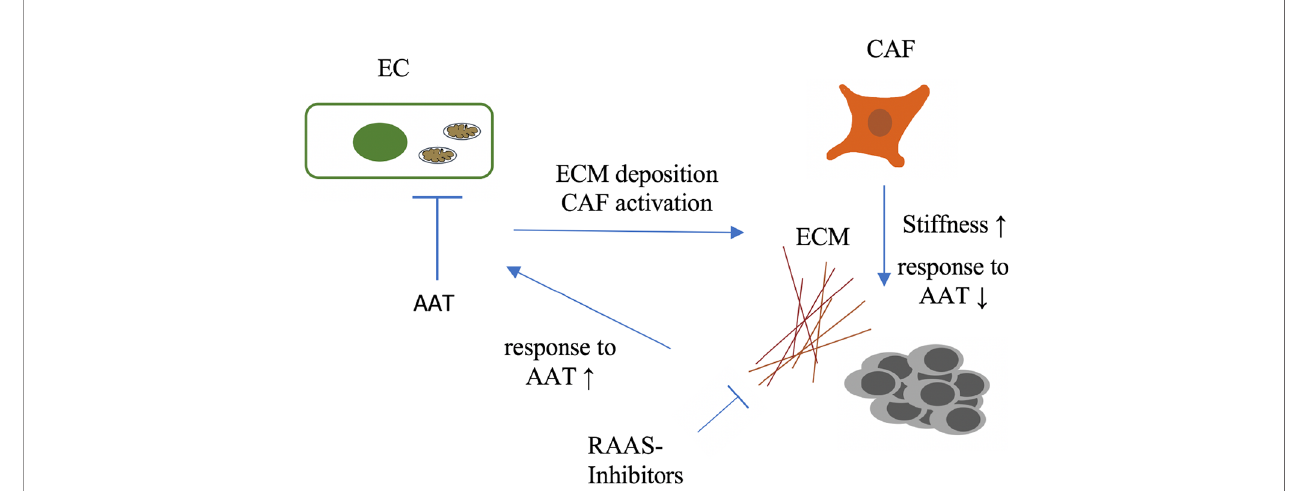
FIGURE 3 | Complex interactions between endothelium and cellular and non-cellular components of the extracellular tumor matrix. Increased tumor stiffness which is in part provoked by AAT itself leads to poor response to AAT and chemotherapy. Tumor stiffness can be targeted by inhibitors of the RAAS, sensitizing patients to therapy. EC, Endothelium; ECM, extracellular matrix; CAF, cancer-associated fi broblast; AAT, anti-angiogenic therapy; RAAS,